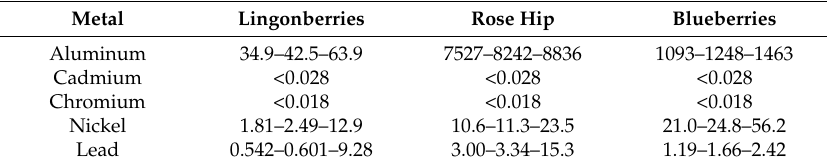
Table 3. Minimum–mean–maximum metal content in fruit material (mg/kg d.w. 1 ), n =